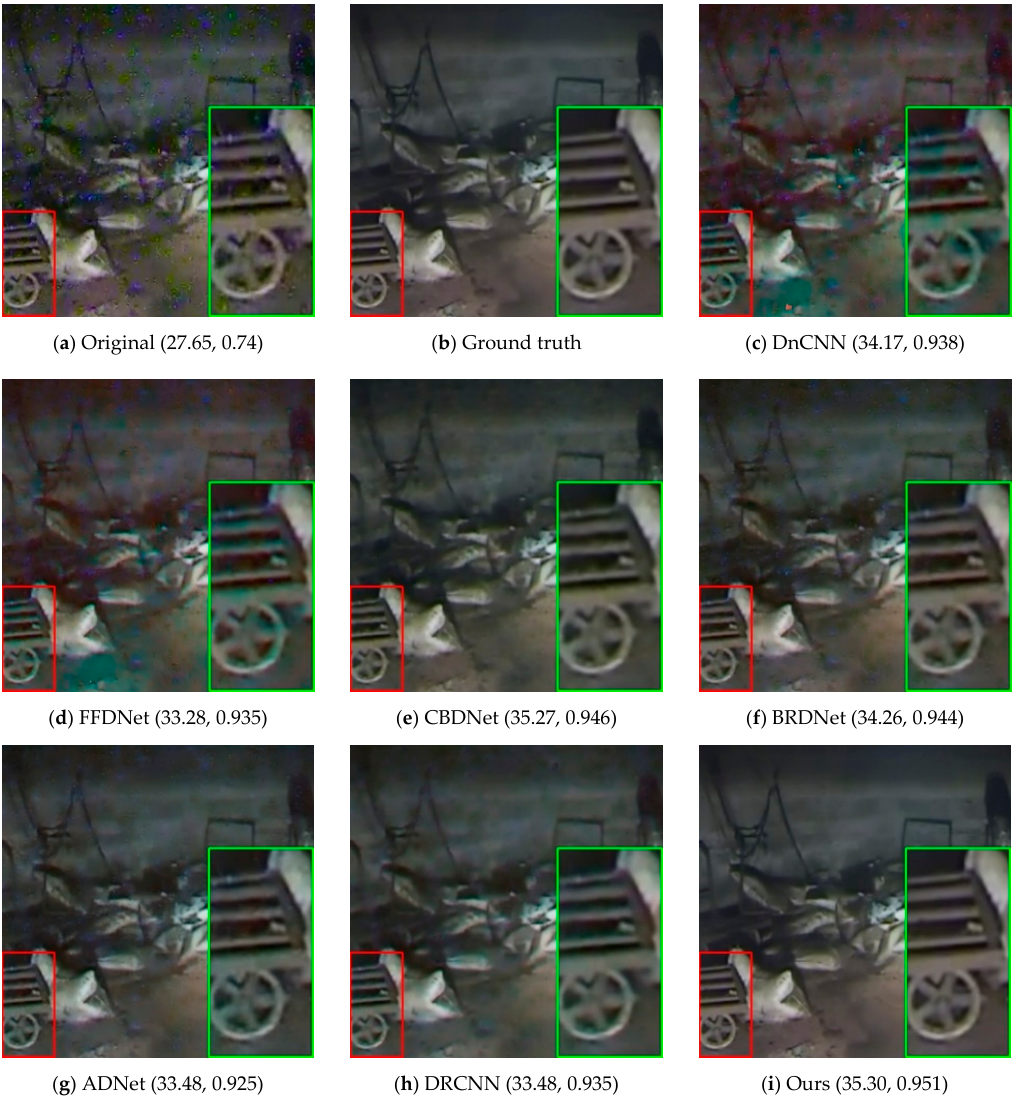
Figure 8. Comparison of results of a nuclear radiation image. ( a ) is the original noised image; ( c - h ) are the denoised results obtained from six popular CNN-based methods; ( i ) is our denoised result. There is a value tuple under each subfigure, and the values in the tuple are, respectively, the peak signal-to-noise ratio (PSNR) and structural similarity (SSIM) calcu- lated with the ground truth clean image shown in ( b ).